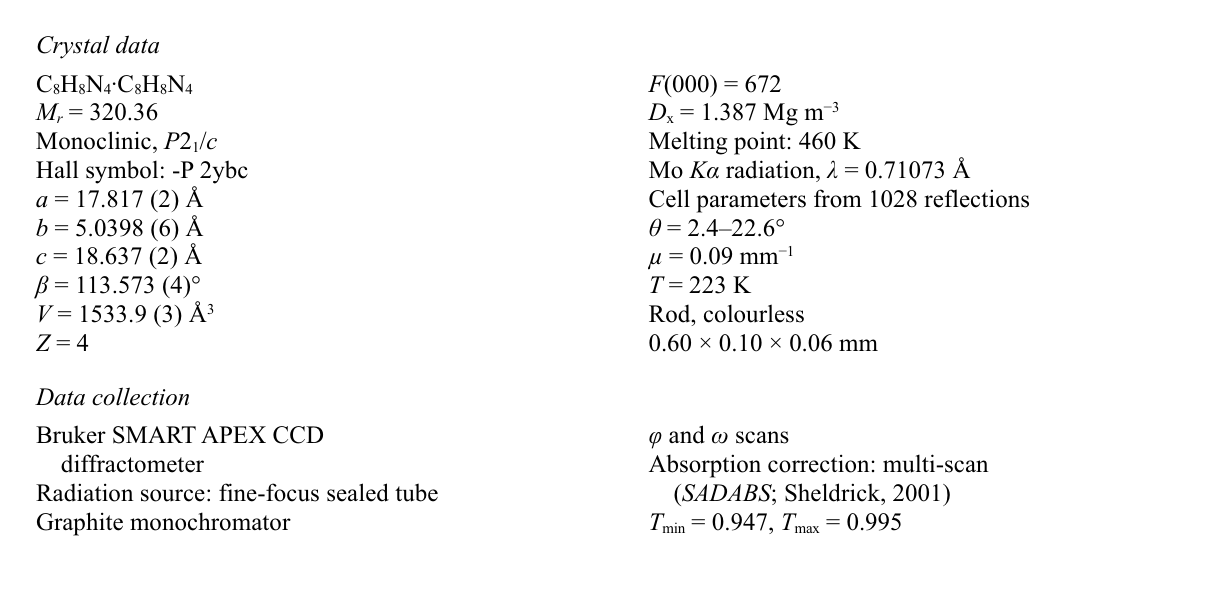
Molecular packing in the crystal, viewed along the b axis. Hydrogen bonds are shown as dashed